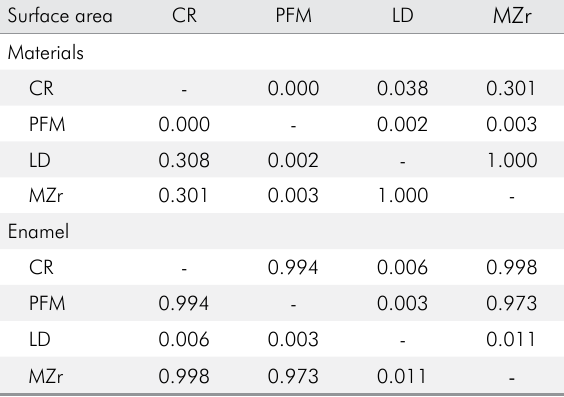
Table 3. Multiple comparisons among the tested materials by post hoc Tukey HSD test for wear